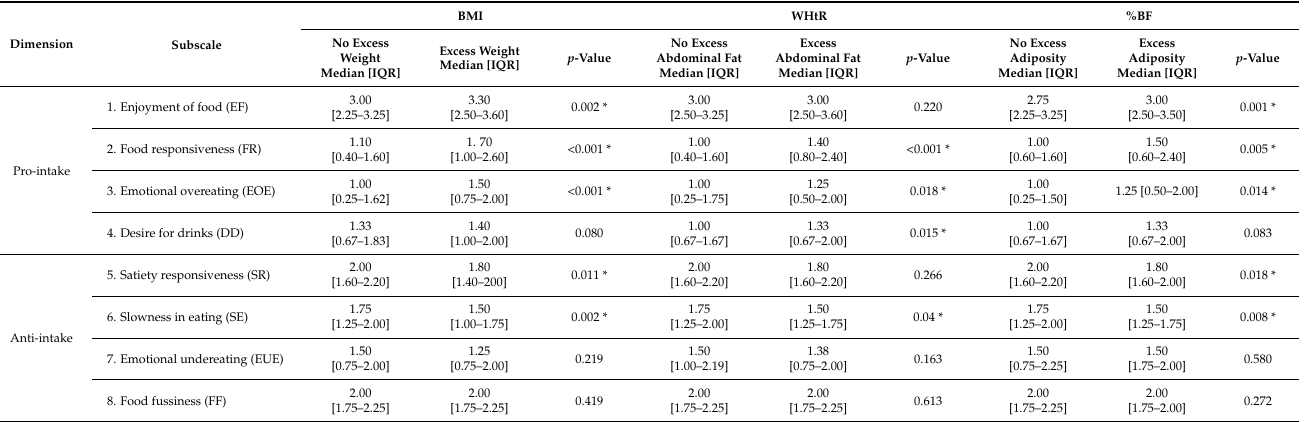
Table 2. Comparison of the mean scores of the CEBQ subscales according to nutritional status assessed by BMI, WHtR and %BF.